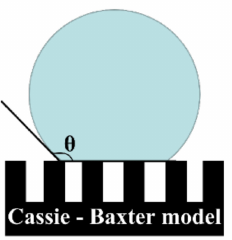
Figure 2. The Cassie-Baxter wetting